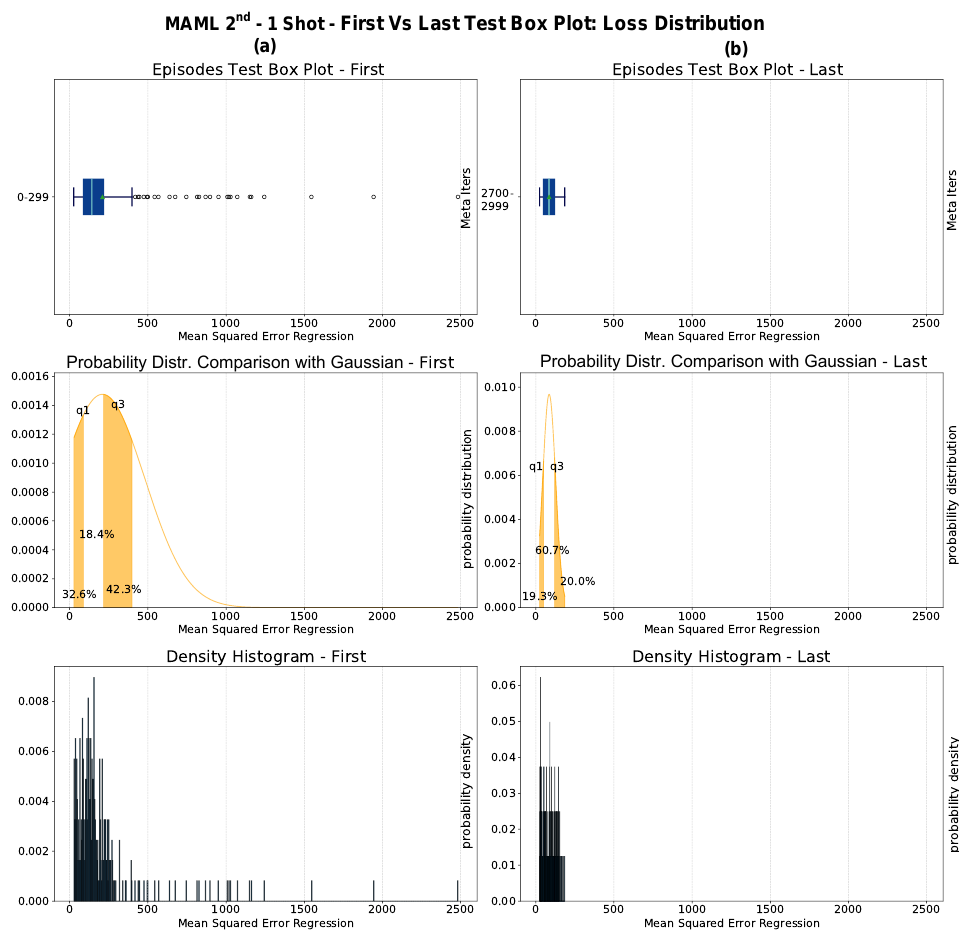
Figure 15. MAML 2 nd 1–shot experiment histograms for the first ( a ) and last ( b ) set of 300 episodes. The box plots in the topmost plots also contain outliers as small circles outside the whiskers. The mid-plots show an approximation to the Gaussian distribution. The lower plots show the true histograms, which do not underlie a Gaussian distribution. The q1 and q3 represent the first and third quartiles, respectively.